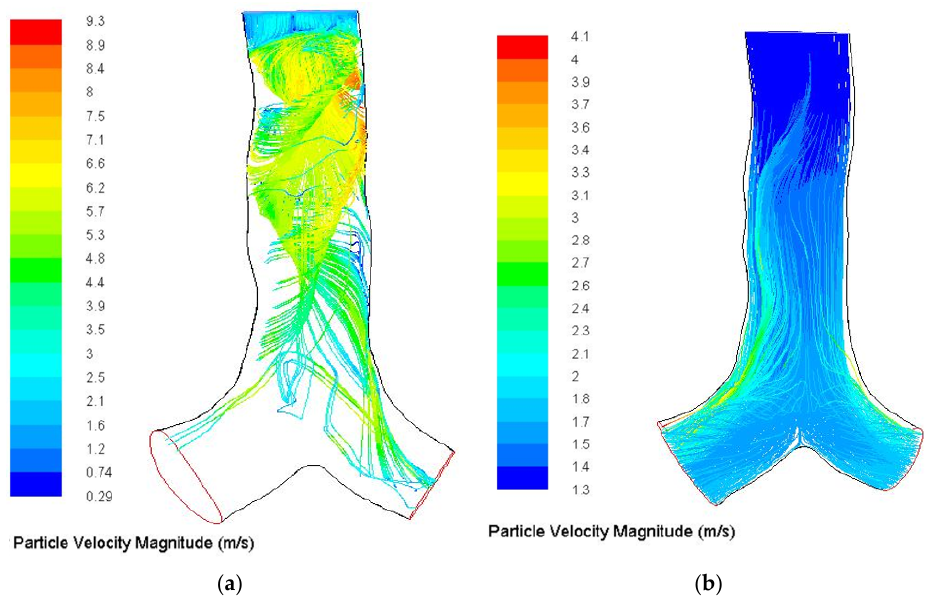
Figure 4. 10-µm diameter particles track streamlines in the upper airways with and without collision, ( a ) with interaction and ( b ) without interaction. Particle traces are based on particle velocity magnitude.